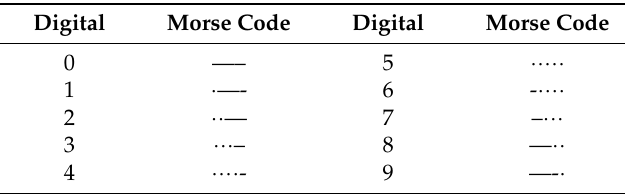
Table 2. Morse code table (standard version).